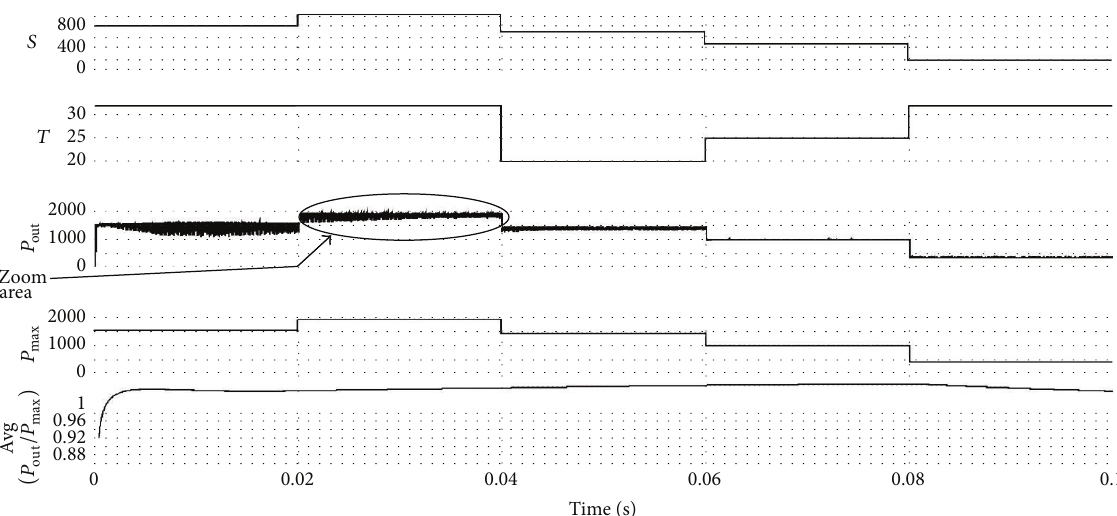
Figure 8: Irradiance profile ( 𝑆 ), temperature profile ( 𝑇 ), extracted power ( 𝑃 and average efficiency obtained with P&O